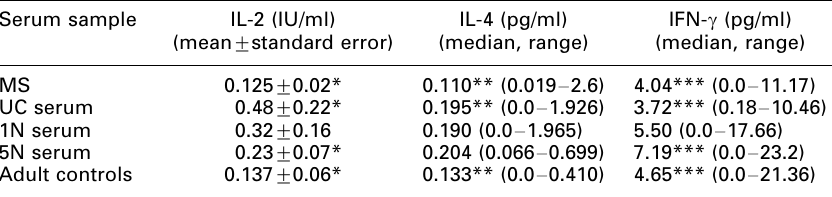
Table 2. IL-2, IL-4 and IFN- g concentrations in MS, UC, 1N and 5N samples and controls Serum sample